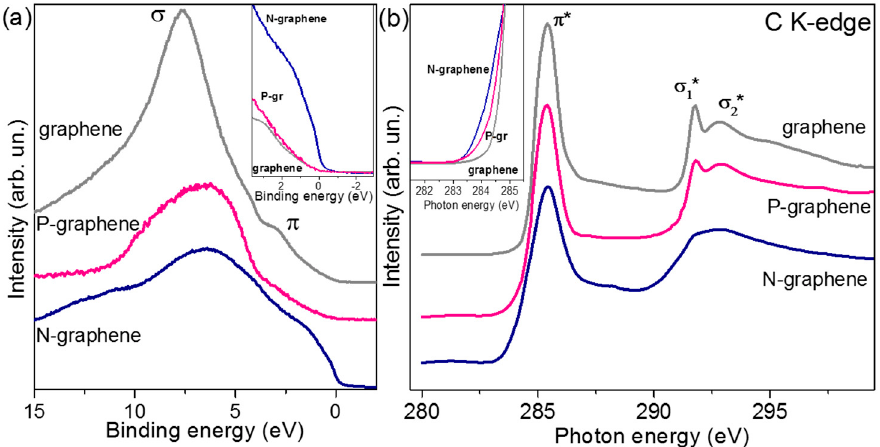
Figure 4. ( a ) Valence band XPS and ( b ) near-edge X-ray absorption fine structure (NEXAFS) C K-edge spectra of the annealed graphene, N-graphene, and P-graphene films. Inserts show the spectra near the Fermi